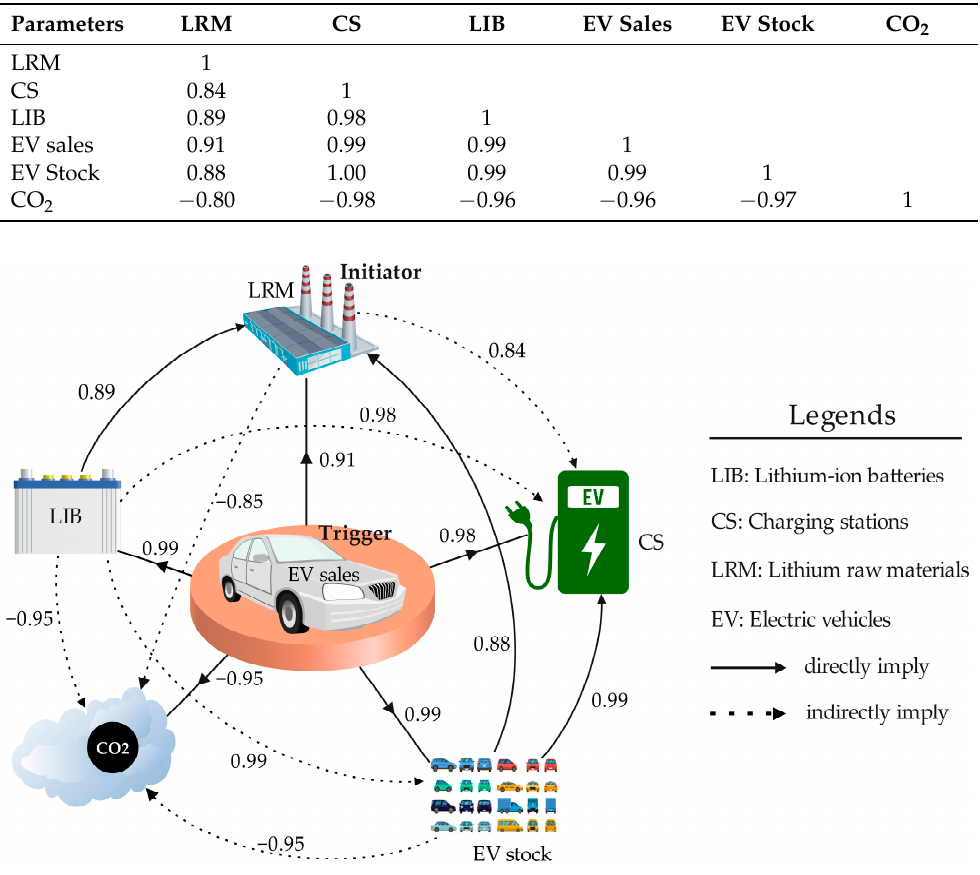
Here, all six (6) variables involved in the cycle, which are LIB, CS, LRM, EV sales, EV stock, and CO 2 emissions from road transport, have been examined. Apart from the EV sales factor, which is considered the skeleton of the entire system, some other factors have either direct or indirect influence on others. In Error! Reference source not found. , black Table 4. Correlation coefficients of parameters involved in the lithium-EV simplified supply channel. line arrows that show direct influence and dash line arrows that show indirect influence were used to briefly explain the influential relationship between variables. Considering the arrows of “direct or indirect implication” in Error! Reference source not found. , it